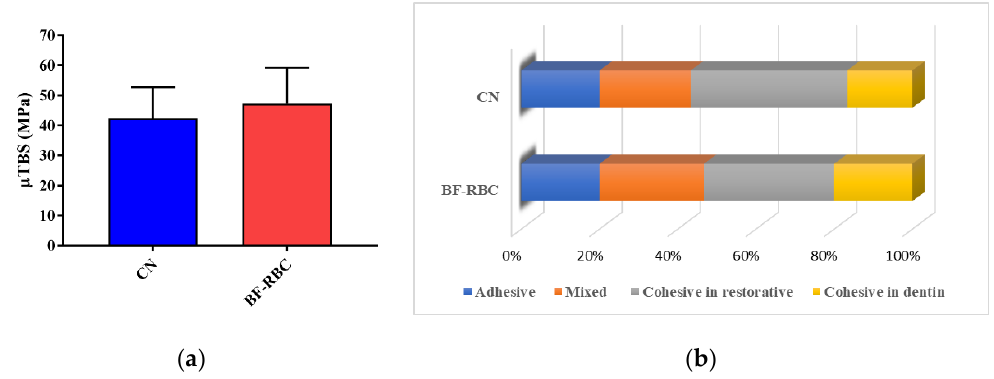
Figure 2. ( a ): μTBS for CN and the BF-RBC ( b ): Frequencies of failure modes for CN and the BF-RBC.